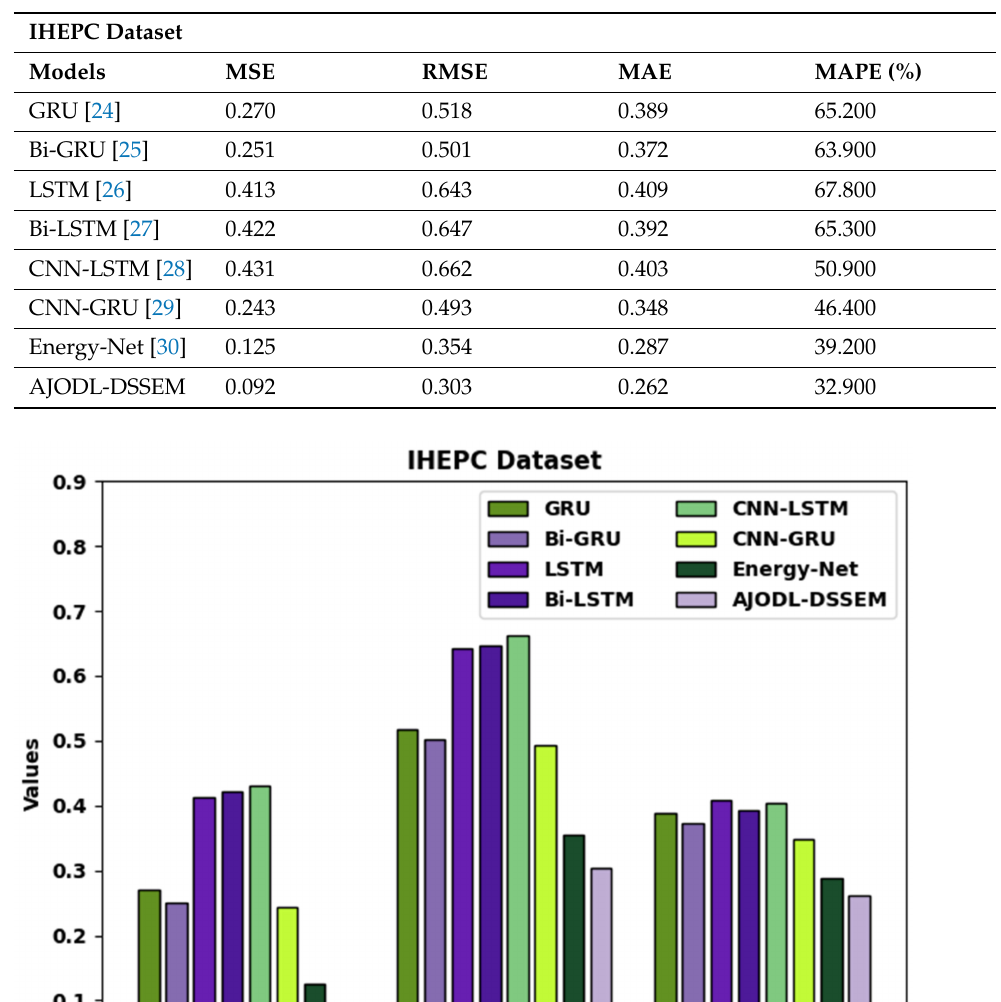
Table 4. Comparative analysis of AJODL-DSSEM technique with existing approaches under